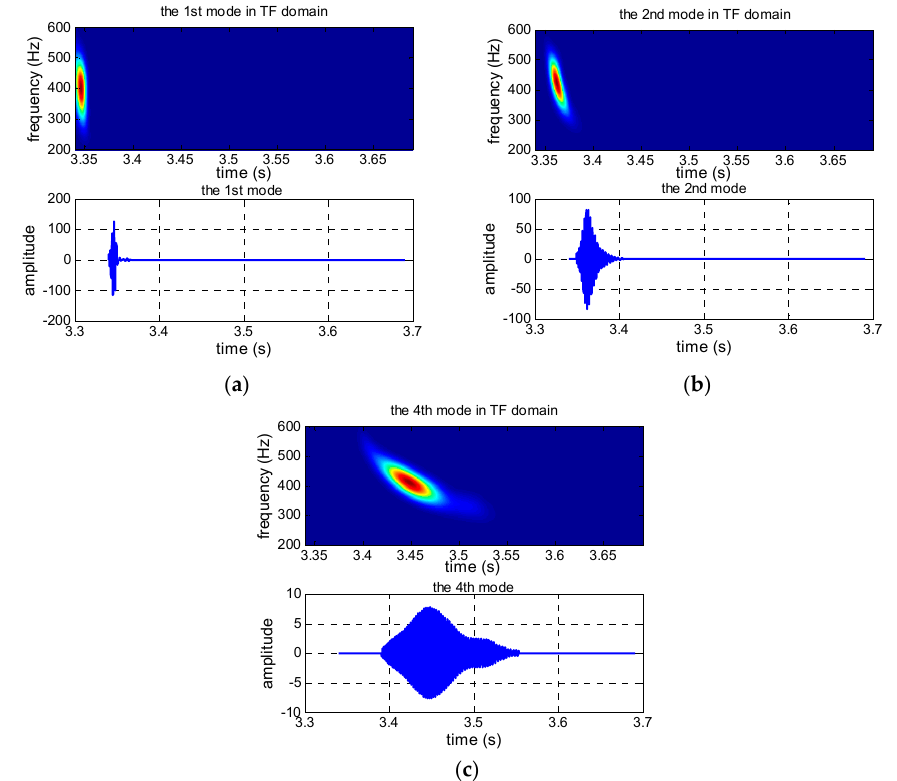
Figure 12. Extracted results of the 1st, 2nd, and 4th modes: ( a ) the 1st mode; ( b ) the 2nd mode; ( c ) the 4th mode.